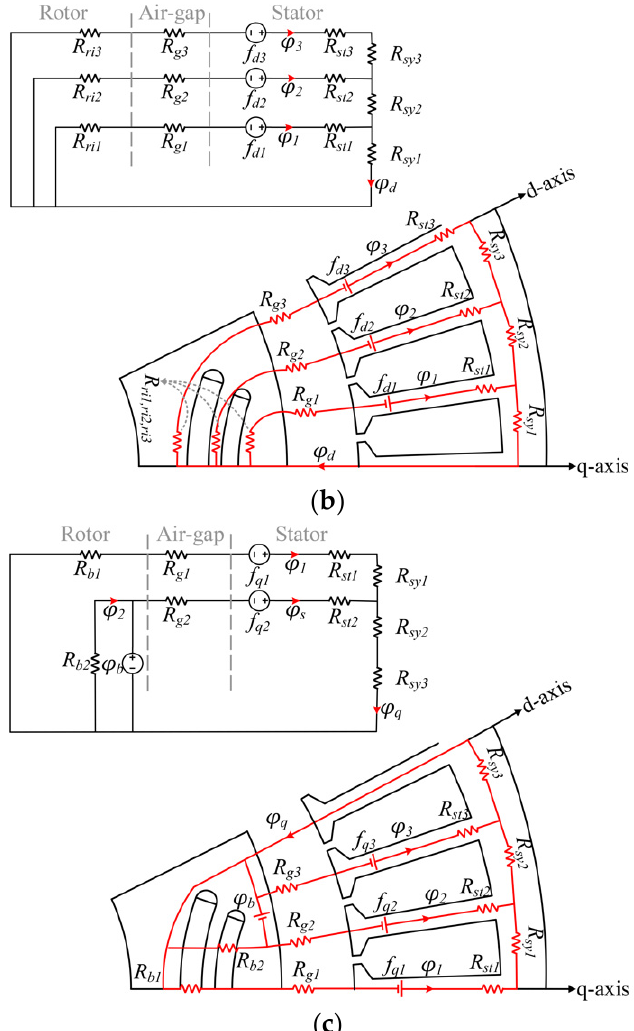
Figure 6. PMASynRM: ( a ) Phasor Diagram, ( b ) d-axis MEC, and ( c ) q-axis MEC. In terms of a PMASynRM, the PM flux linkage ( λ PM ) should be included in Equation (2). • d-axis (Figure 6b): Considering a five-phase drive system, the stator phase voltage ( V s ) and d-q axes voltages ( V d and V q respectively) can be defined with the phase resistance, stator current as r s , I s , air-gap flux linkage vector of the stator, the rotor angular speed, permeability of the air as Λ s , ω r , µ 0 , air-gap length and radius, machine stack length as l g , r g , and finally magnetomotive force (MMF) harmonics of the stator and rotor, stator current phase angle as L , f s , h , f r , h , and γ d . (See Equations (3)–(8))